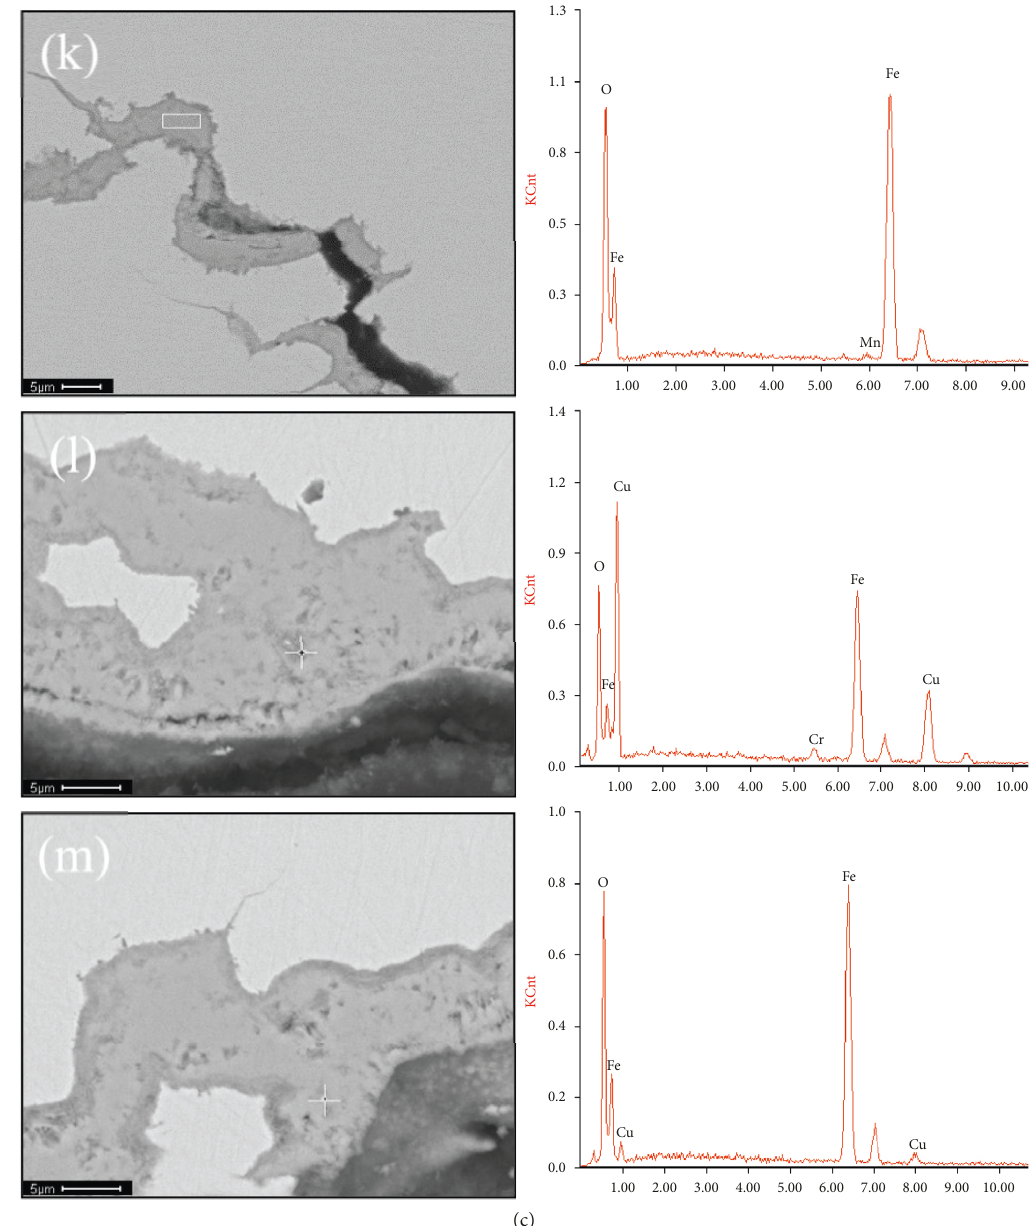
Figure 12: Scanning electron microscope analysis of X -1. (a) The X -1 crack. (b) Micromorphology of the crack surface. (c, h) Energy spectrum analysis. (d, e) Crack micromorphology. (f) Cleavage characteristic. (g, i) Local crack morphology. (j) Copper-rich particles. (k) Energy spectrum analysis of iron oxide. (l) Energy spectrum analysis of copper-rich particles. (m) Energy spectrum analysis of copper-rich